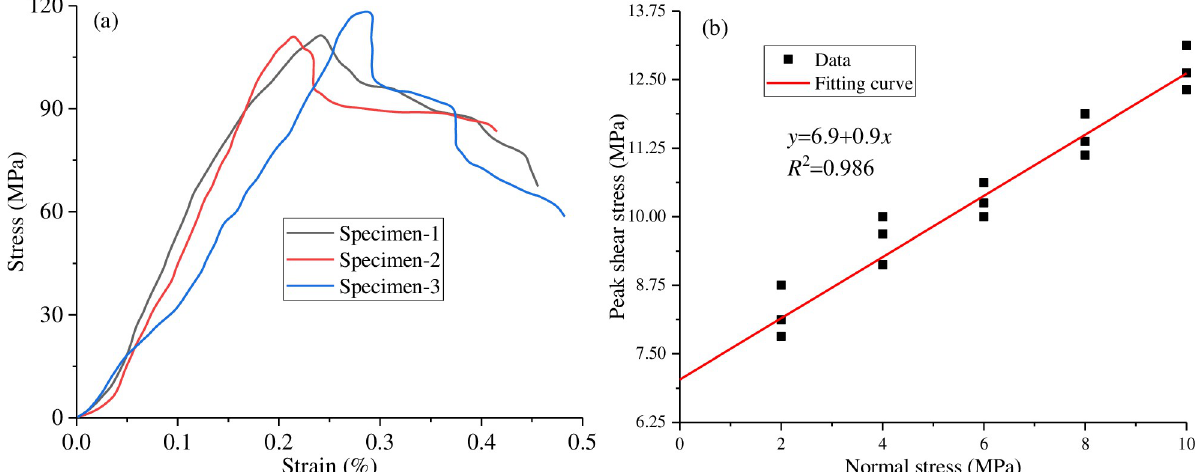
Fig 2. Conventional curve: (a) Uniaxial stress-strain curve; (b) Peak shear stress curve under normal stress.